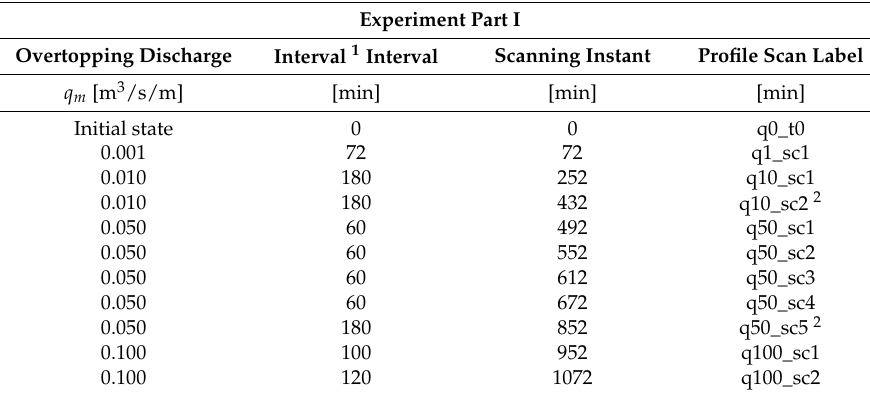
Table 1. Experimental storm conditions for part I of Millingen